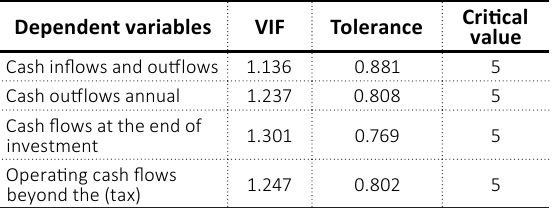
Table 4. VIF’s results